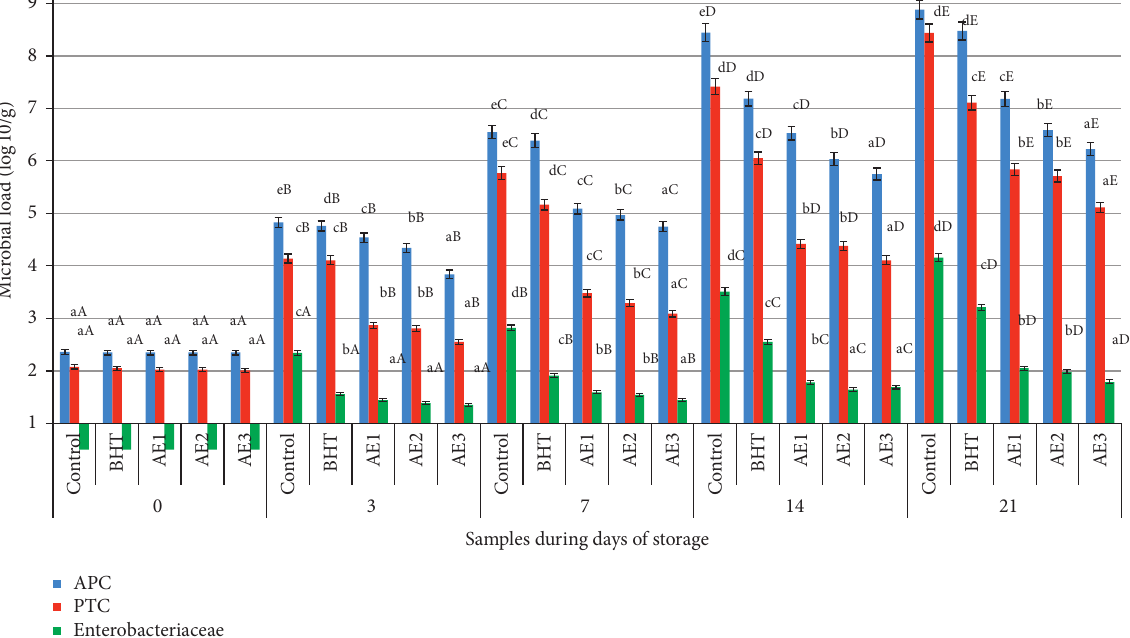
Figure 8: Effect of the aqueous pomegranate peel extract on the microbial load of aerobic plate count (APC), psychrotrophic count (PTC), and Enterobacteriaceae count of raw minced meat beef during storage at 4 °